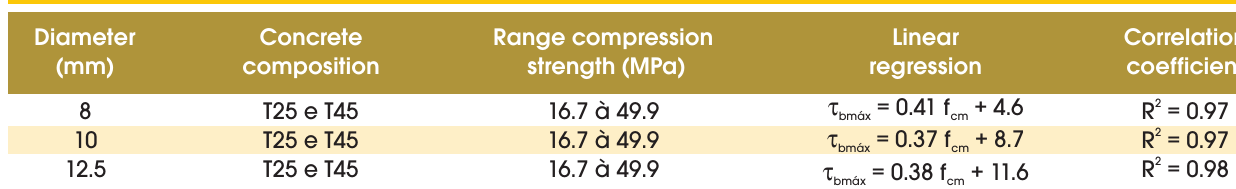
Table 6 – Equations of linear regression lines and their correlation coefficients Diameter